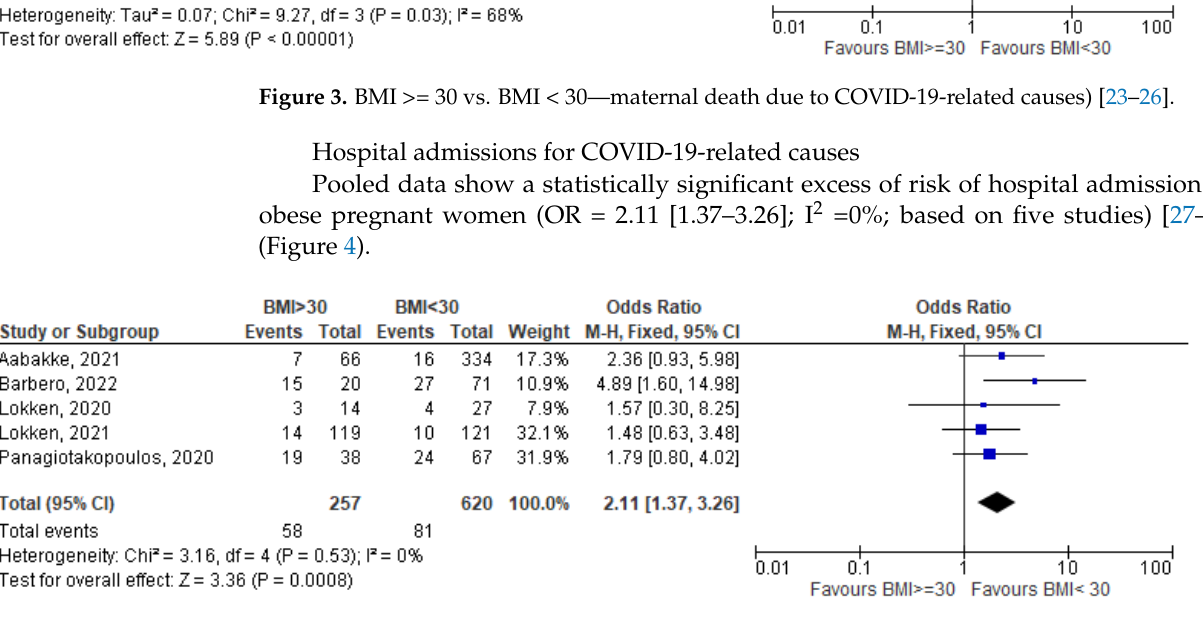
Figure 4. BMI >= 30 vs. BMI < 30—hospital admissions for COVID-19-related causes [27–31]. Figure 4. BMI > =30 vs. BMI < 30 — hospital admissions for COVID-19-related causes [27 – 31]. Figure 4. BMI > =30 vs. BMI < 30 — hospital admissions for COVID-19-related causes [27 – 31]. Vitamin D serum Figure 4. BMI > =30 vs. BMI < 30 — hospital admissions for COVID-19-related causes [27 – 31]. Vitamin D serum levels Vitamin D serum levels Vitamin D serum levels